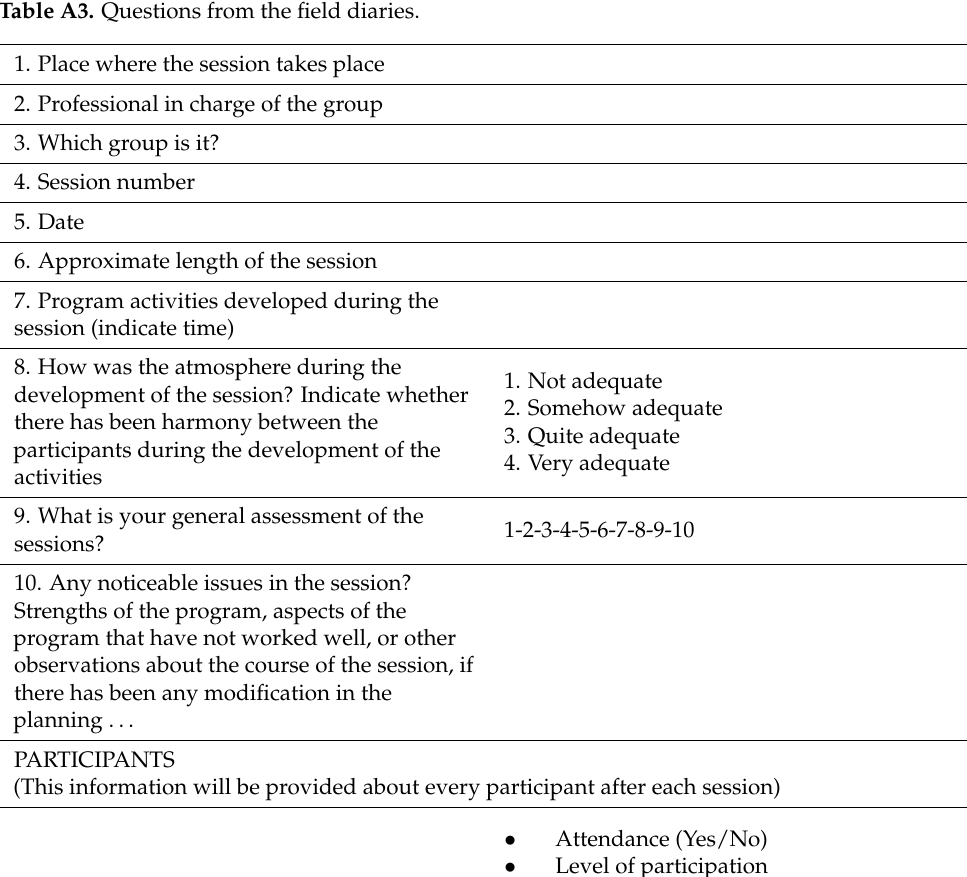
Table A3. Questions from the field